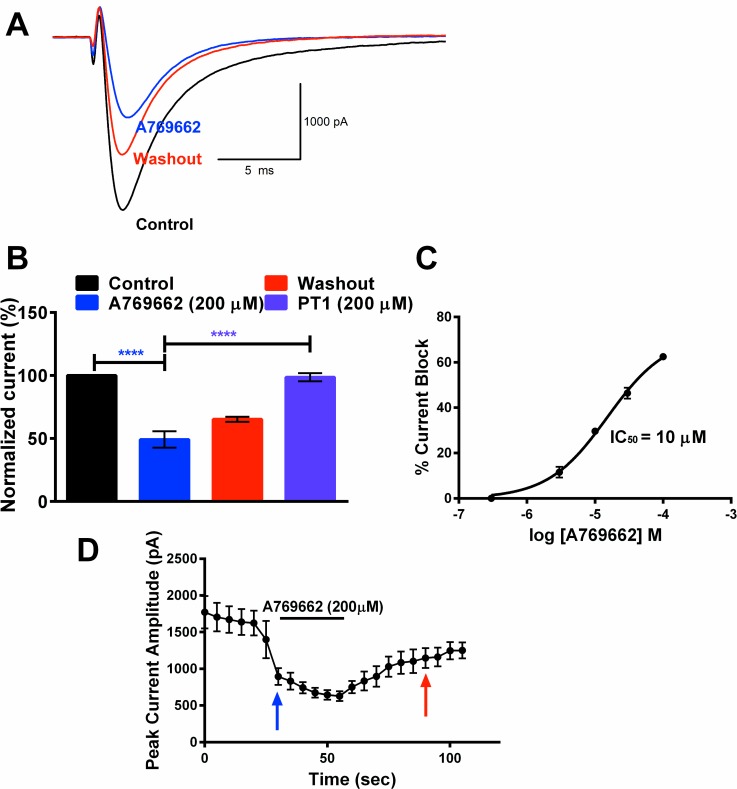
A769662 dose-dependently blocks rat TG VGSC current amplitude.(A) Representative Na+ current traces in TG neurons in the presence of A769662. Currents were elicited in TG neurons with a current step protocol initiated from -80 mV to 0 mV for 25 msec from a holding potential of -80 mV. (B) Acute application of A769662 reduced the Na+ current amplitude in TG neurons (n = 6, **** p < 0.0001). C) Data generated was fitted to a hill equation to plot the dose response curve for percent current amplitude block by A769662. A769662 inhibited Na+ current amplitude with an IC50 of 10 μM. D) Peak current vs time plot of the effect of A769662 on Na+ current amplitude. Arrows correspond to A769662 (blue) and washout (red) in A) and B).